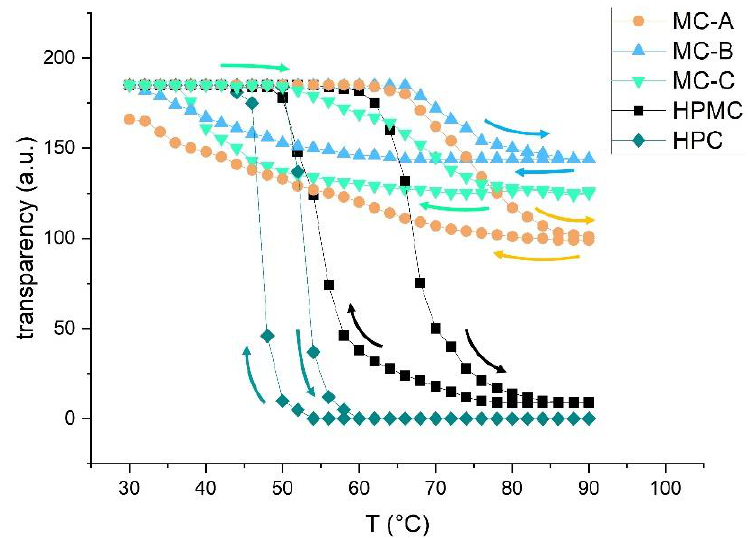
Figure 3. Transparency as a function of temperature during a thermal cycle from heating to cooling at 1 °C/min for 1 wt % aqueous solution of pure cellulose ethers.